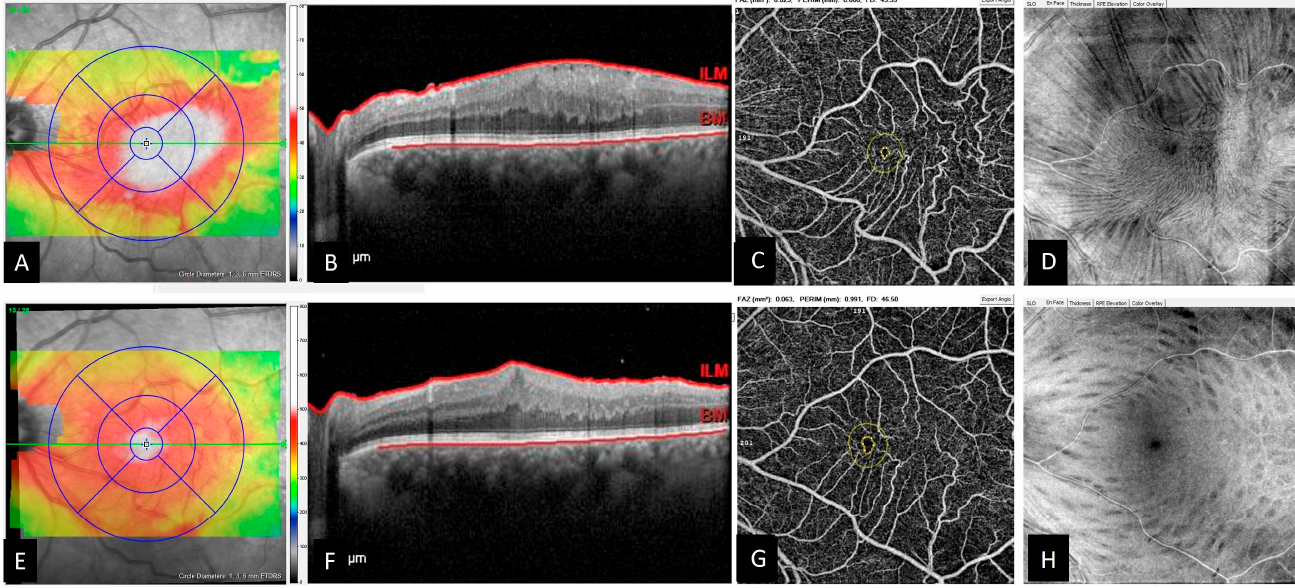
Figure 2. OCT and en-face OCTA images of a 67-year-old male before and after idiopathic epiretinal membrane (iERM) surgery. ( A ) Preoperative retinal thickness map calculated by the software of SD-OCT device showed the increased retinal thickness. The central subfield thickness was 545 µ m. ( B ) The horizontal B-scan SD-OCT passing through the fovea revealed a stage 3 epiretinal membrane: The reflectivity of the ectopic inner foveal layers is similar to that of the inner nuclear layer. ( C ) The en-face OCTA image shows measured foveal parameters including foveal avascular zone (FAZ) area (0.025 mm 2 ), FAZ perimeter (0.666 mm), and foveal vessel density (43.59%). Note the increased retinal vessel tortuosity. ( D ) En-face OCT reveals the surface traction. ( E ) Postoperative retinal thickness map showed the reduction in retinal thickness. The central subfield thickness was 511 µ m. ( F ) The horizontal B-scan OCT passing through the fovea revealed an absence of foveal pit. ( G ) After iERM surgery, all the measured foveal parameters increased (FAZ area = 0.063 mm 2 , FAZ perimeter = 0.991 mm, and foveal vessel density (46.50%). ( H ) The surface traction was relieved together with decreased vessel tortuosity. Note the inner retinal dimples coursing along the path of the nerve fiber layer caused by the internal limiting membrane